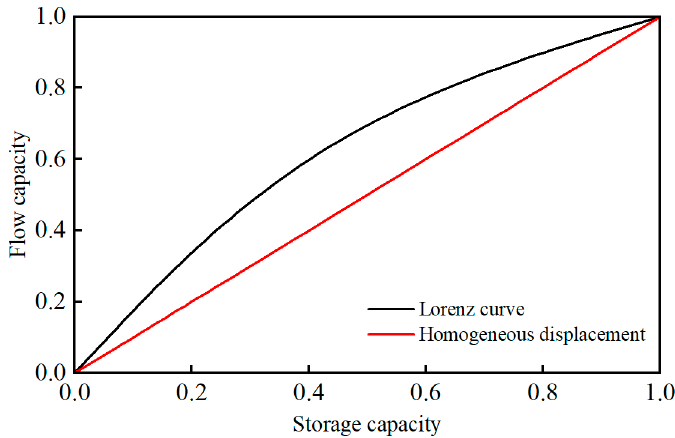
Figure 1. Typical storage-capacity–flow-capacity Lorenz curve.